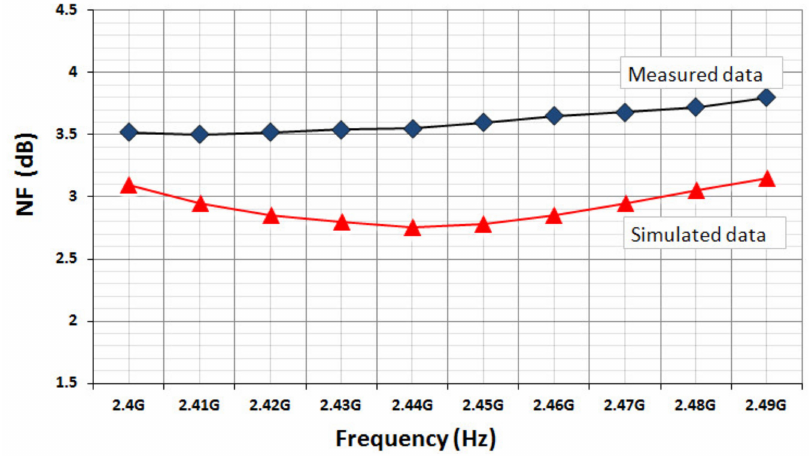
Figure 11. Measured and simulated NF versus input frequency with a fixed IF frequency of 2